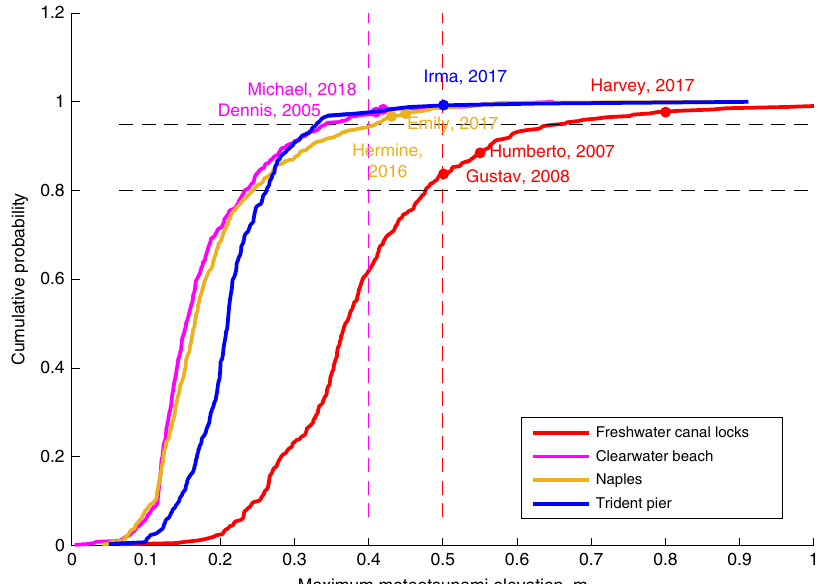
Fig. 3 Cumulative distribution of the maximum meteotsunami elevations. Cumulative distributions (lines) of the maximum meteotsunami elevations at the tide gauges where the extreme tropical cyclone (TC)-triggered meteotsunamis were observed: Freshwater Canal Locks (red), Naples (gold), Trident Pier (blue) and Clearwater Beach (magenta). The cumulative distributions were computed considering all the meteotsunami events between years 1998 and 2018. The maximum meteotsunami elevations of the most eight extreme TC-induced meteotsunamis are indicated with dots. The intersection of the cumulative distributions with the discontinuous gray lines represent the 80% and 98.5%